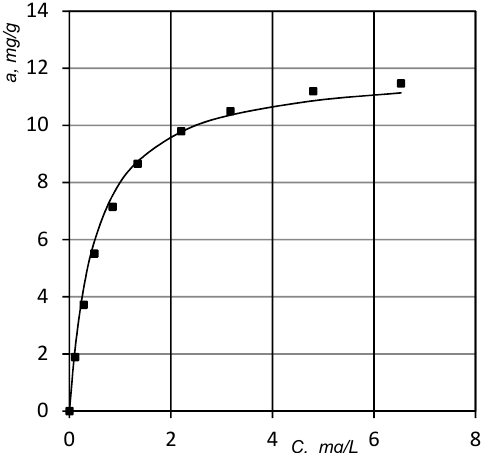
Figure 9. Diazepam adsorption isotherm for activated charcoal; T= 37.0